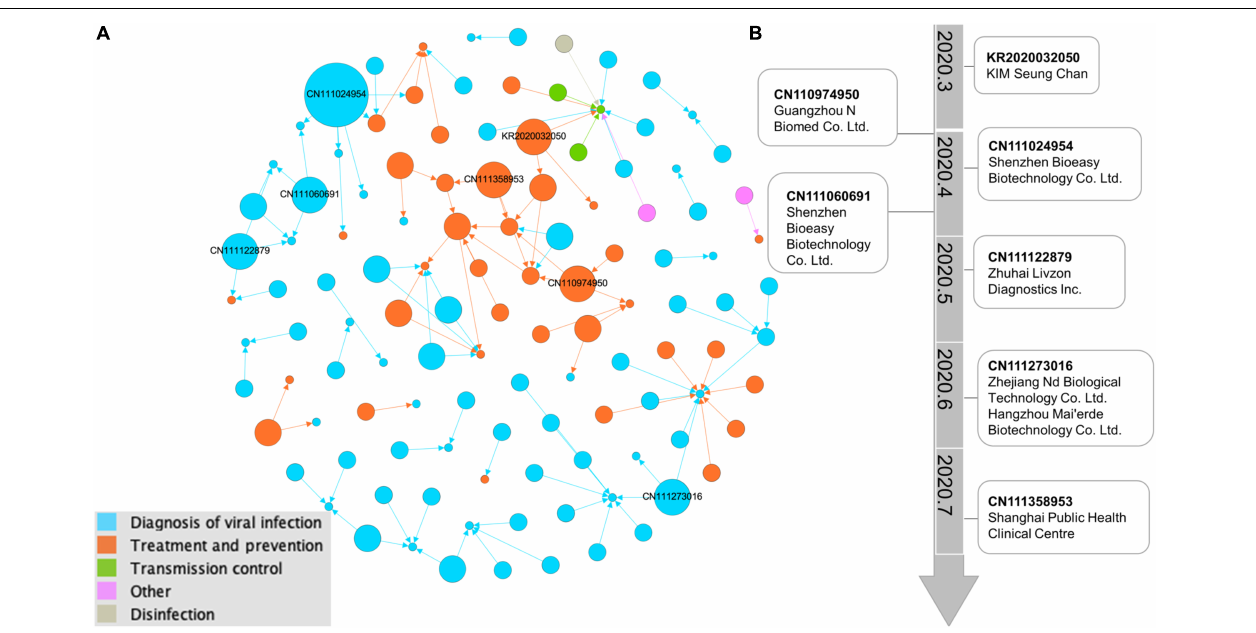
FIGURE 4 | Network visualization map of citations by COVID-19 patents. (A) Citation network illustrating the evidence sources cited in 117 recommendation patent documents. The larger the circle is, the more frequently the patents received citations. Lines represent the citation direction. The force-directed layout algorithm of “Fruchterman Reingold” by Gephi is used to make the network distribution. Different circle colors indicate different technologies. (B) The main path from the typical key-route citation weighted with the top 10 patents of citation out-degree. In the visual analysis of the main path based on patent citation, time was added to the technology trajectory calculated by Gephi software, which clearly shows the research focus and direction of this field in different time